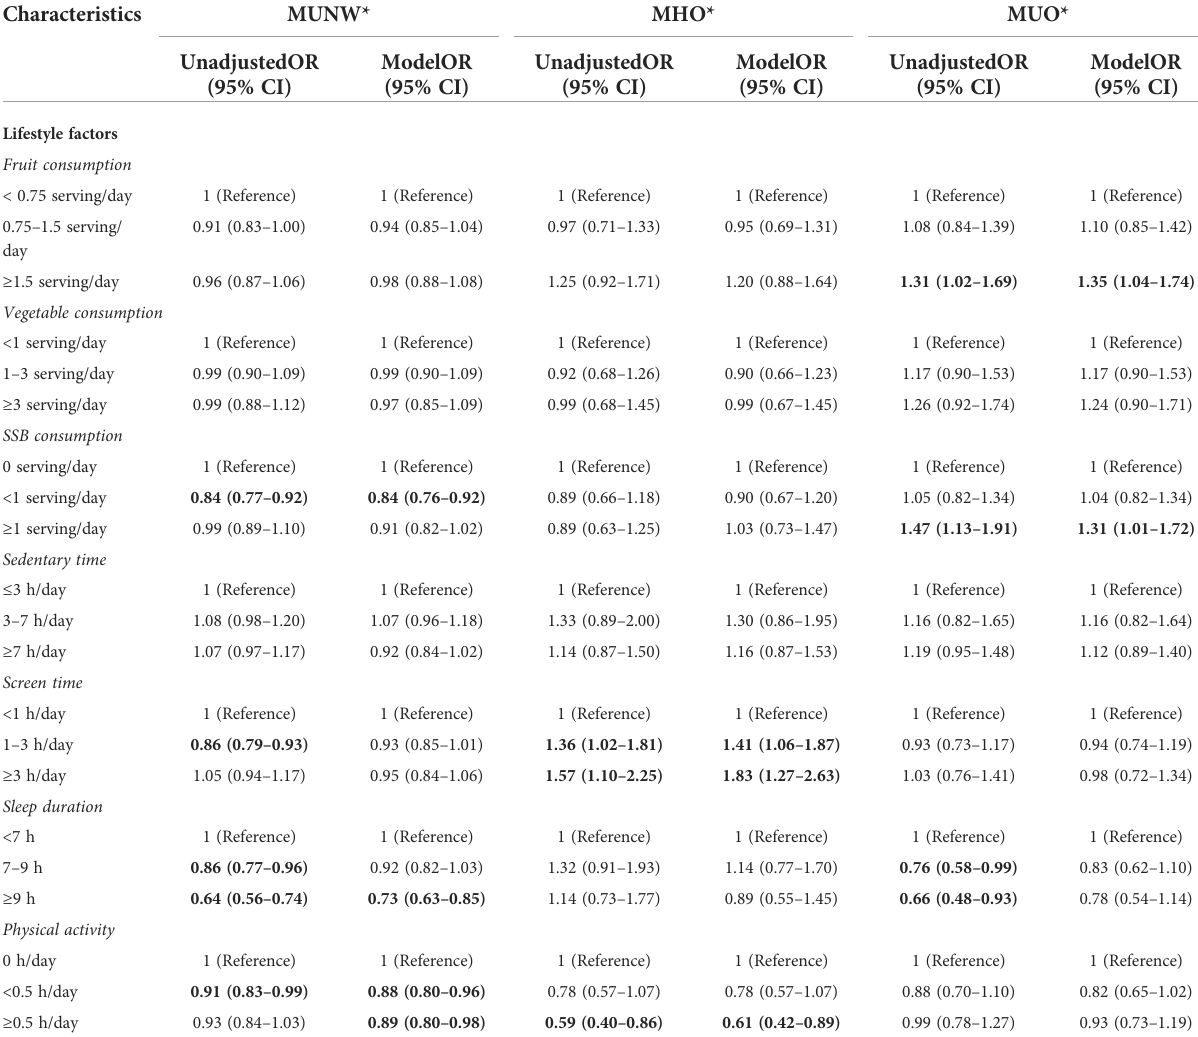
TABLE 5 Odds ratios for different metabolic obesity phenotypes associated with lifestyle factors, based on 2018 consensus-based